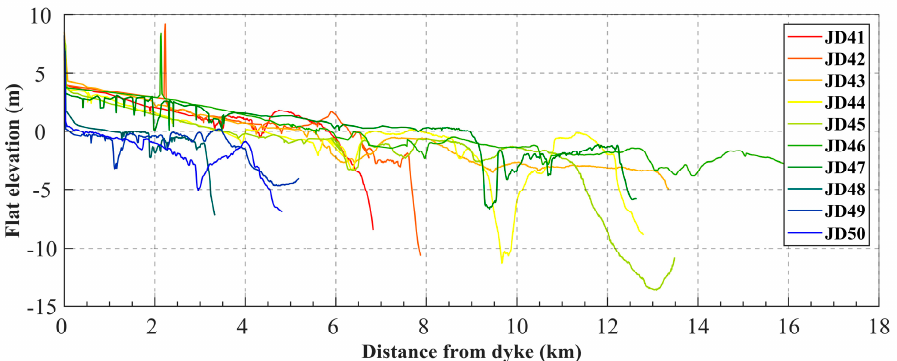
Figure 6. Measured bed elevation of the 50 profiles.